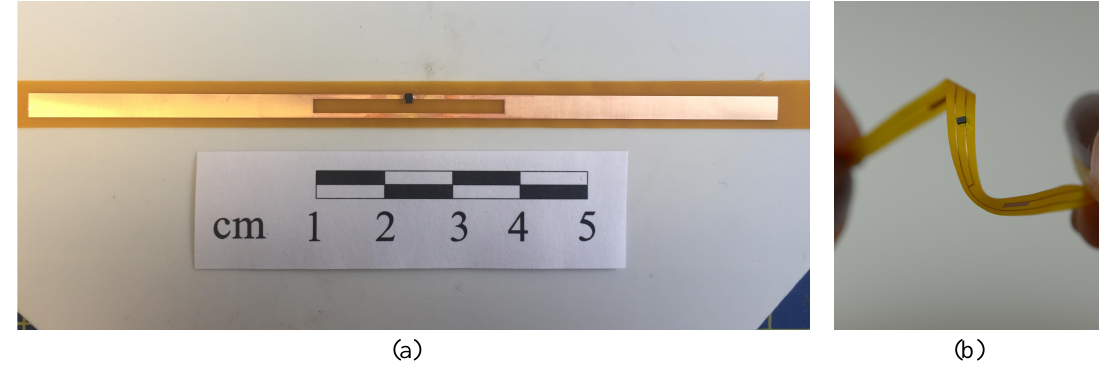
Figure 3. Photograph of the fabricated RFID prototypes: ( a ) the proposed RFID antenna with the mounted IC, ( b ) bending of an RFID tag fabricated using the proposed